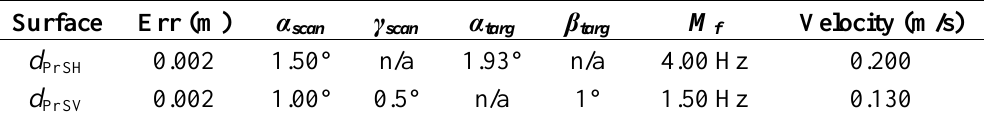
Table 6. Assessment of errors for the horizontal and vertical profile spacing tests by quantifying the uncertainties in any of the input parameters that might account for errors in the real world